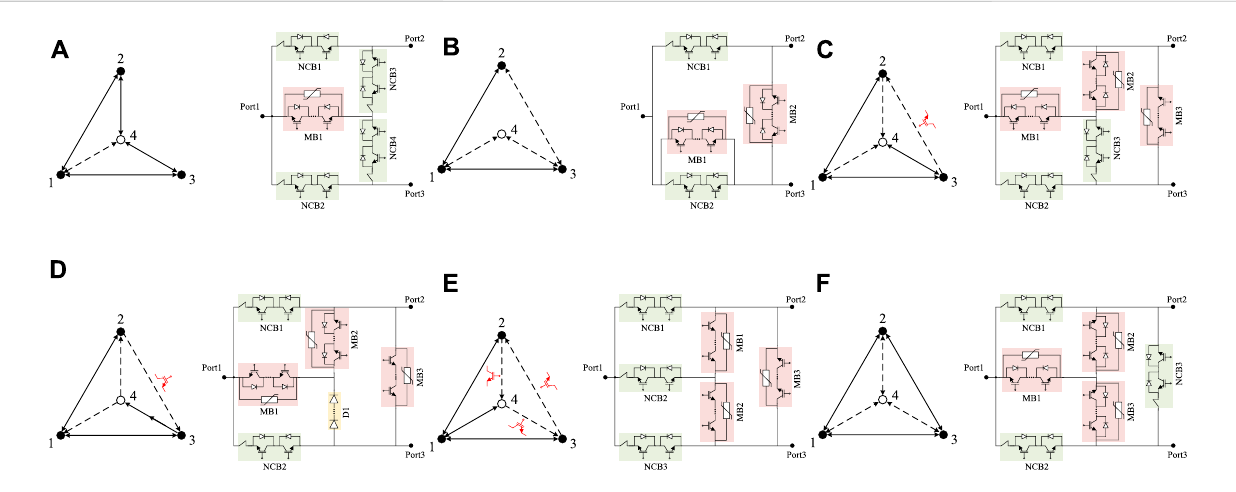
FIGURE 9 Three-port HCB topologies searched by the algorithm in the one common connection point situation: (A) Output 913, (B) Output 1,027, (C) Output 1,033, (D) Output 1,034, (E) Output 1,057, and (F) Output